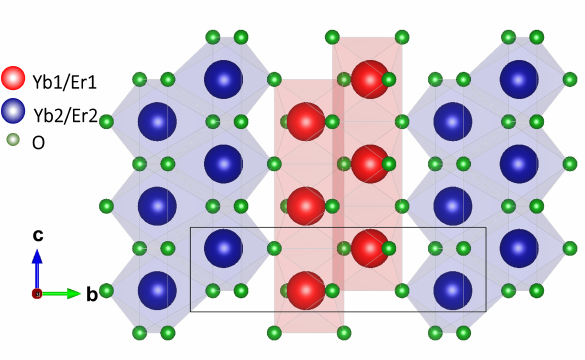
Figure 1. Visualization of the atomic structure of SrLn 2 O 4 . Two different types of zigzag chains— red (chain 1-Yb1/Er1) and blue (chain 2-Yb2/Er2)—run along the c -axis, and oxygen atoms (in green) form different octahedra around Yb/Er ions. Sr ions (not shown) fill the columnar cavities. The drawings were generated using the software VESTA